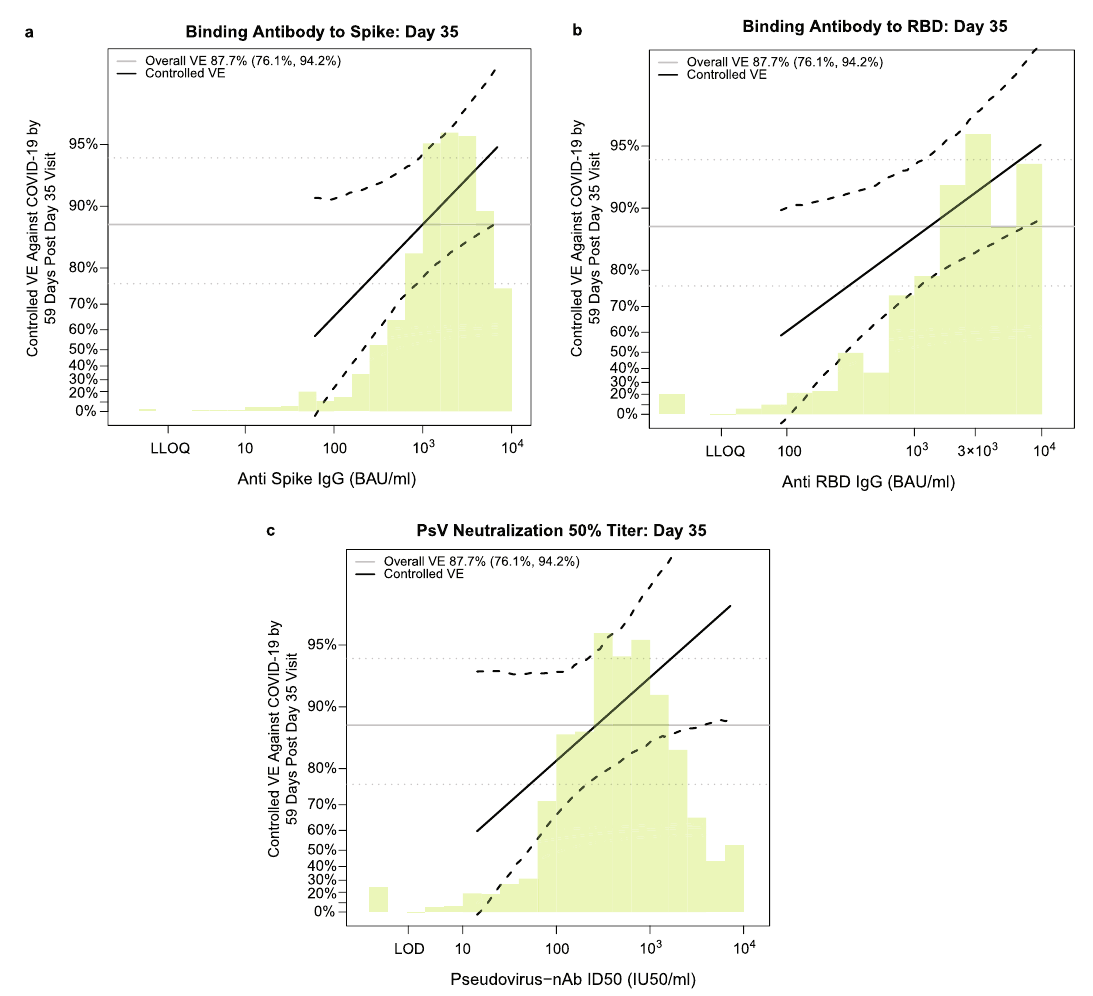
Fig. 5 | Vaccine ef fi cacy by D35 antibody marker level in baseline SARS-CoV-2 negativeper-protocolvaccinerecipients(U.S.studysites). Curvesshownarefor D35 a anti-spike IgG concentration, b anti-RBD concentration, or c pseudovirus (PsV)-nAb ID50 titer. The dotted black lines indicate bootstrap pointwise 95% con fi dence intervals. The green histogram is an estimate of the density of D35 antibody marker level, and the horizontal gray line is the overall vaccine ef fi cacy from7to59dayspostD35,withthedottedgraylinesindicatingthe95%con fi dence